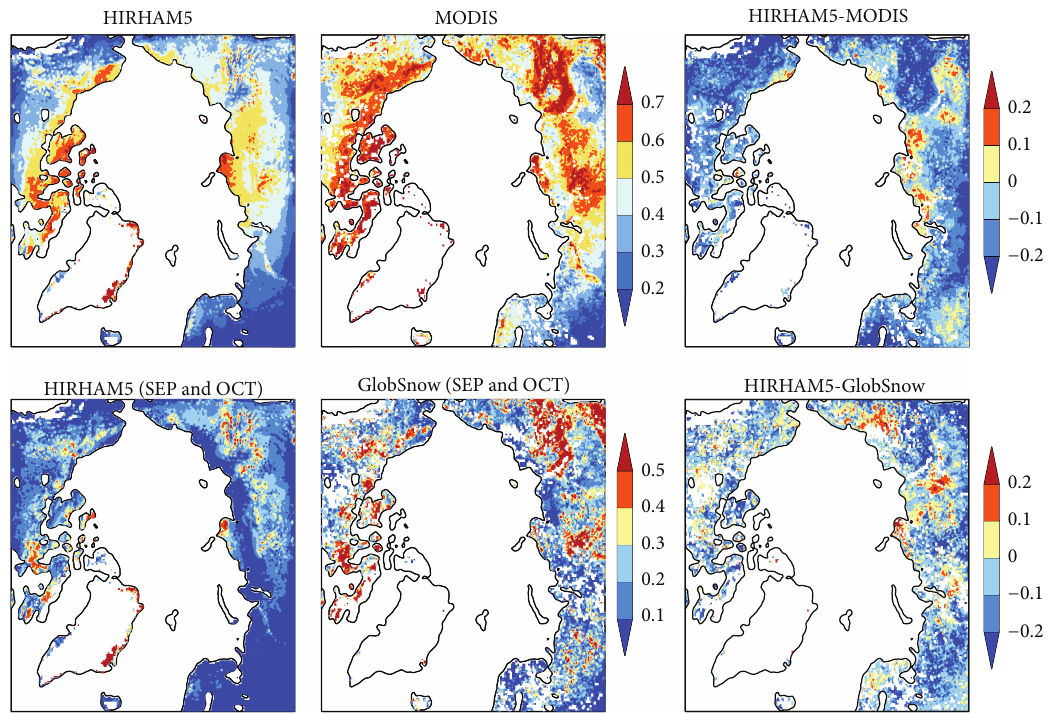
Figure 6: Snow cover fraction averaged over 2008–2010 for autumn derived from HIRHAM5, MODIS, GlobSnow and their corresponding differences “HIRHAM5 minus MODIS” and “HIRHAM5 minus GlobSnow”. Where the GlobSnow average refers to the September-October